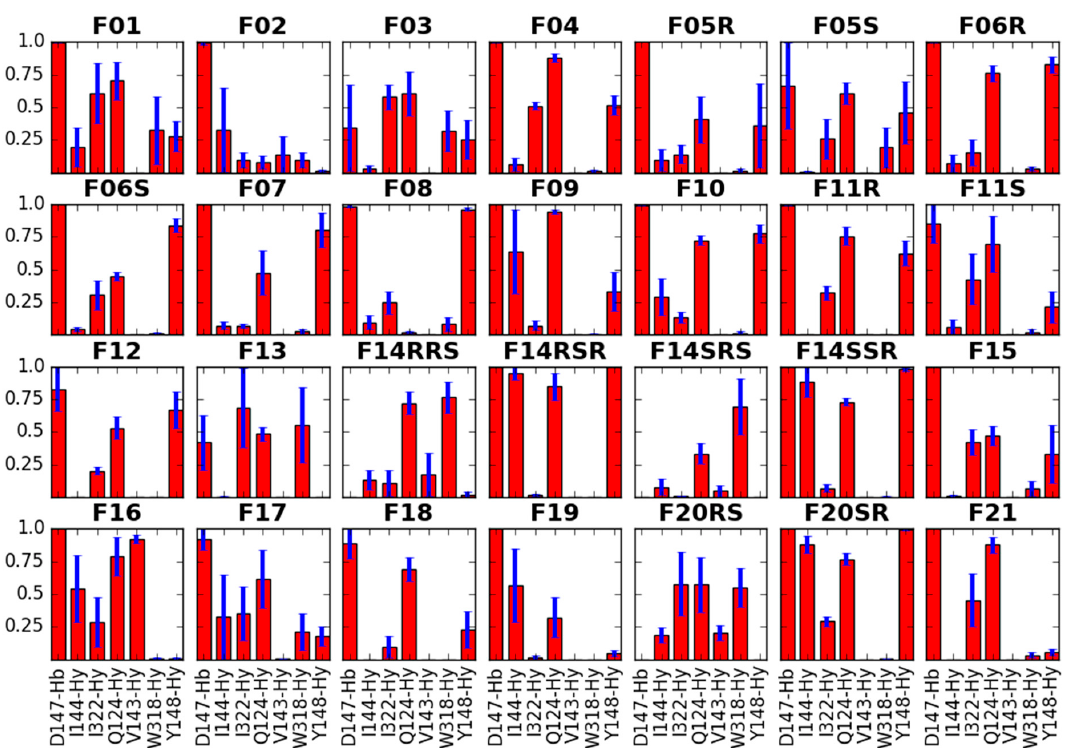
Figure 3. Interactions of the core piperidine with the receptor residues. Red bars represent the mean frequency of contacts with a particular residue, and blue bars show standard error of the mean. Data are collected from last 10 ns of production in 3 replicas. In x -axis label given is the residue’s name and number as well as type of the contact (Hb—hydrogen bond, Hy—hydrophobic, A—aromatic).